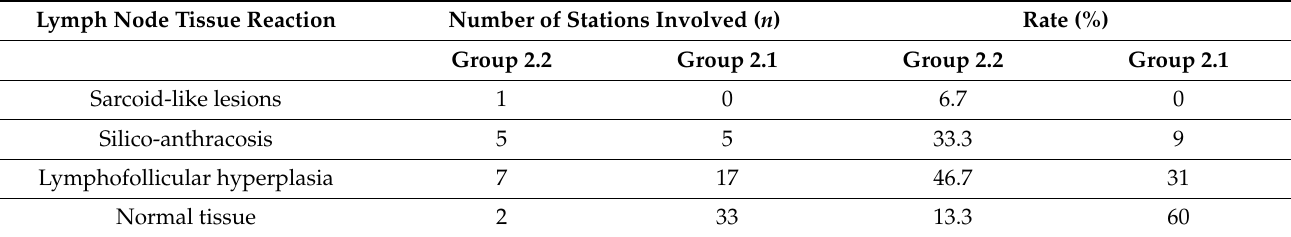
Table 7. Lymph node tissue reactions in comparison between groups 2.2 and 2.1.